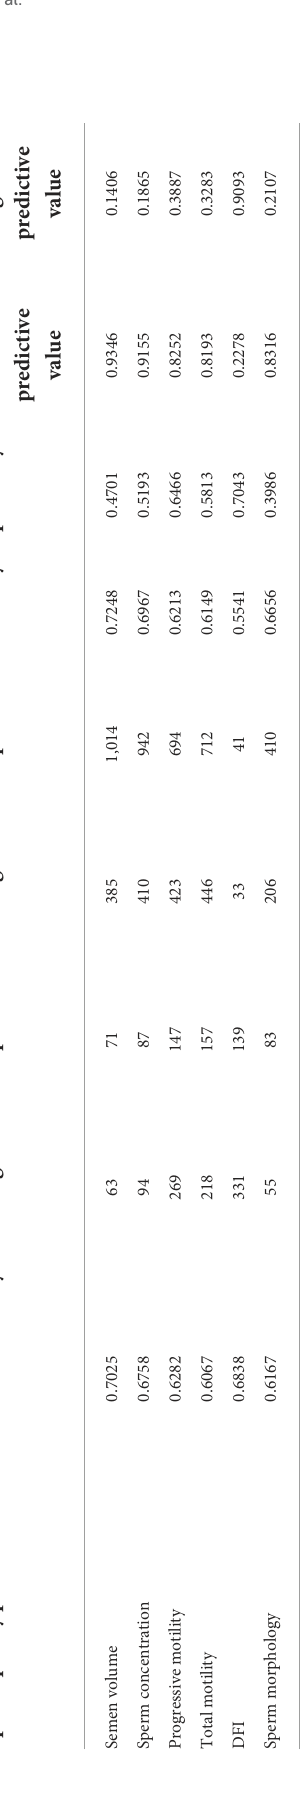
The AUC of the XGBoost models for progressive sperm motility was 0.697 (Figure 5A), and the cross-validation